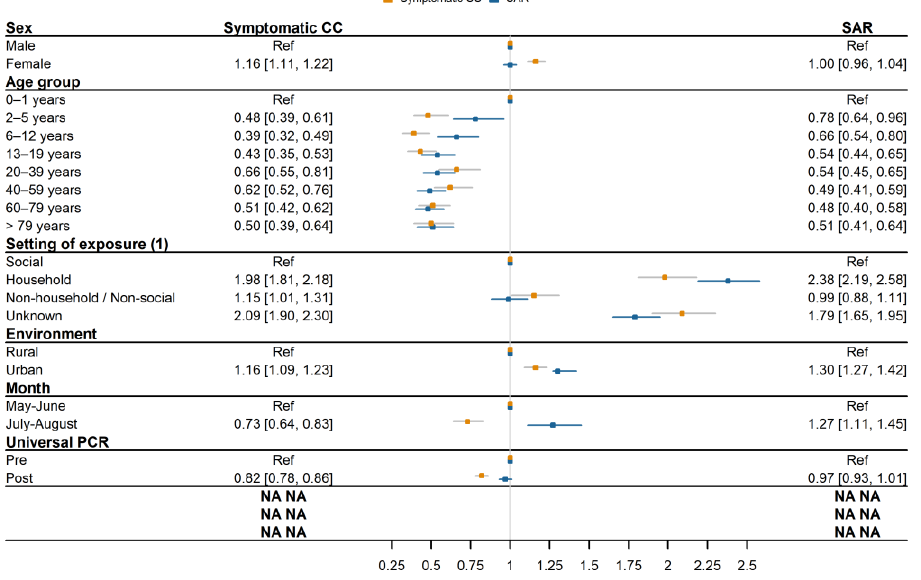
Figure 2. Forest plot displaying associated odds ratio (OR) and 95% confidence intervals of symp- tomatic close contacts (CCs) and the secondary attack rate (SAR).